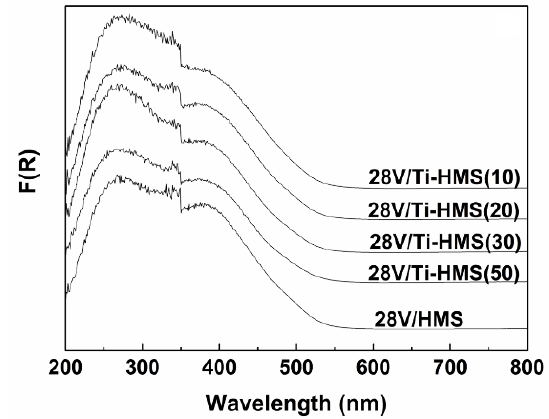
Figure 5. UV-vis spectra of catalysts with different supports.